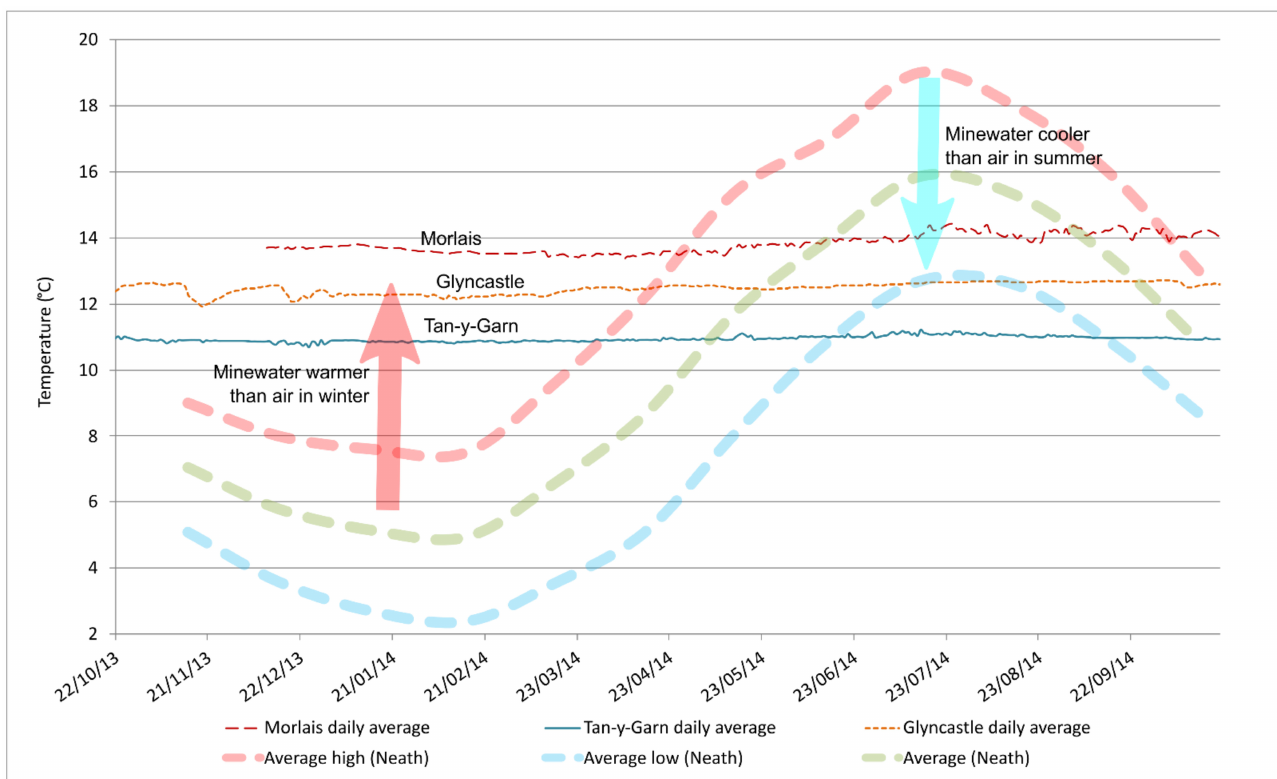
Figure 2. Temperatures of minewater in South Wales, presented as daily averages of half-hourly data recorded in surface outflow point, compared with monthly average high/low air temperatures for Neath in the period 1961–1990 (from https://en.wikipedia.org/wiki/Neath (accessed on 18 June 2021), based on Meteorological Office data). Note that the Tan-y-Garn minewater (3.9849 ◦ W 51.7696 ◦ N; [38,39]) temperature is a little higher than annual average air temperature, while the increasing temperatures at Glyncastle (3.6889 ◦ W, 51.7119 ◦ N) and Morlais (4.0680 ◦ W, 51.7004 ◦ N) and are believed to be due to increasing depth of minewater derivation. Minewater data provided by Gareth Farr, with thanks, as reported in Farr et al.